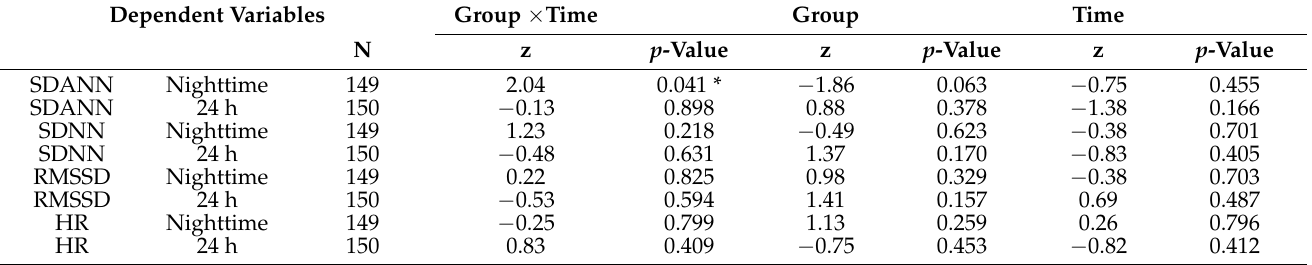
Table 3. The results of linear mixed-effects regression models for HRV parameters.